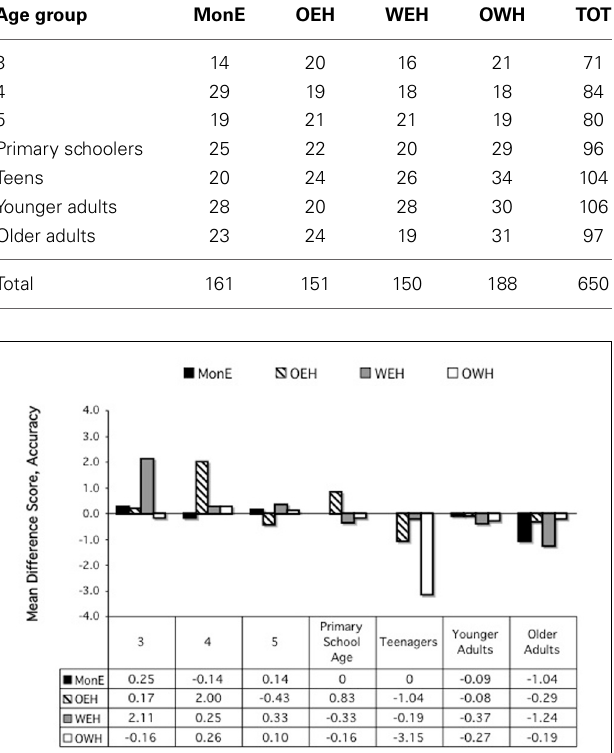
FIGURE 1 | Differences scores, accuracy, on card sort tasks, by age and home language.